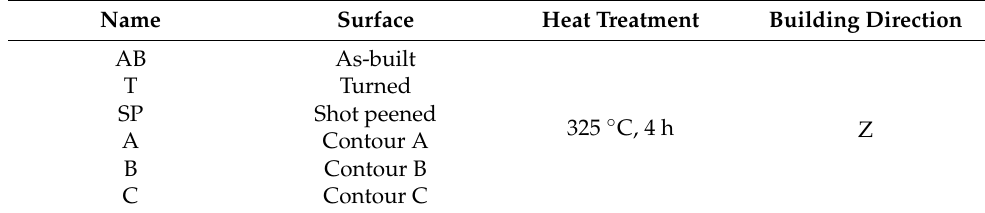
Table 4. Overview of all manufactured and tested fatigue specimens.